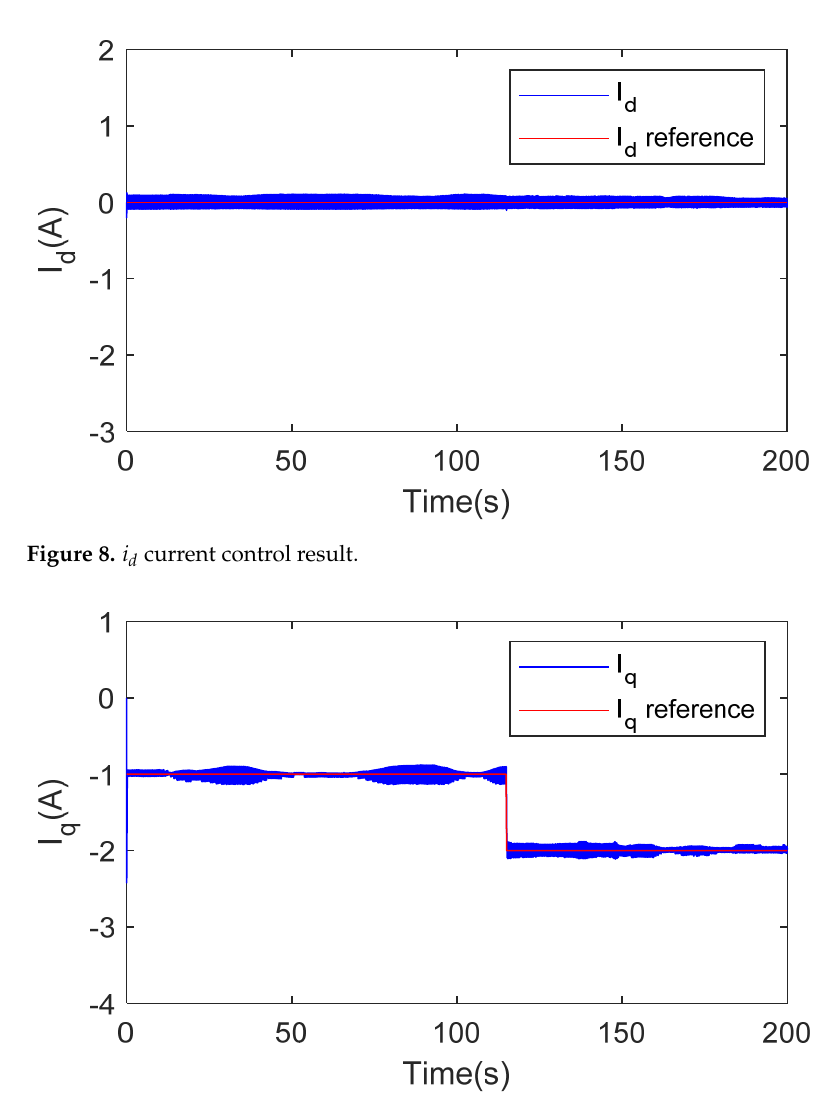
Figure 9. i q current control result.